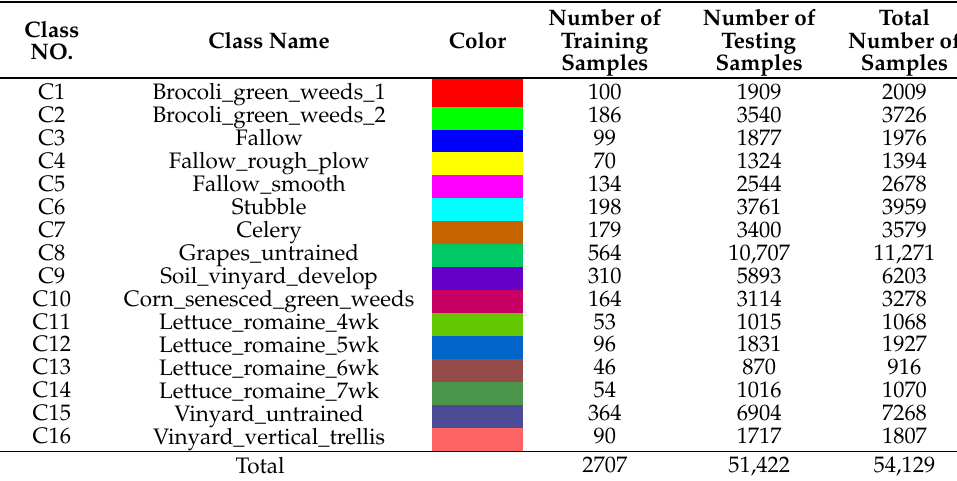
Table 3. Details of the SV dataset.